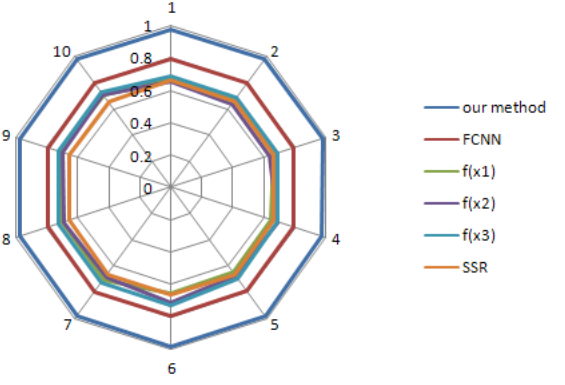
Figure 6. Packet transmission success ratio with varying QL using Gaussian distribution with N (0, σ 2